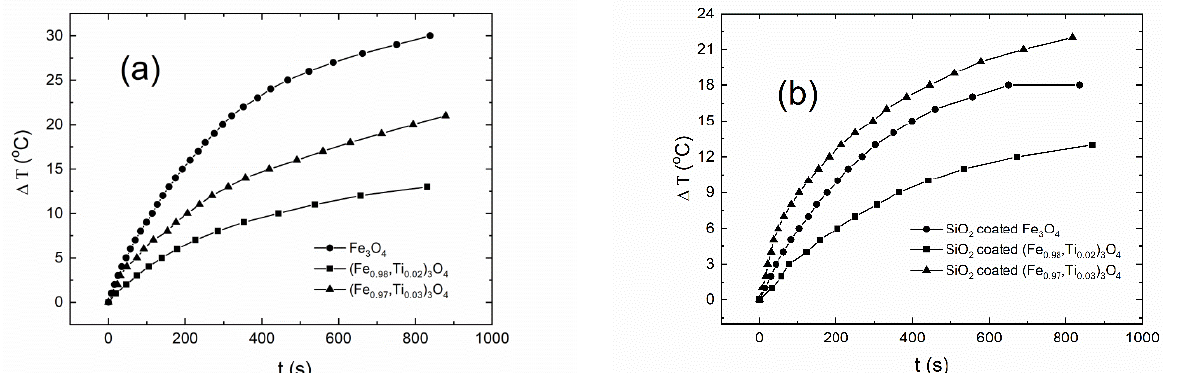
Figure 6. The magnetic heating performance of ( a ) uncoated and ( b ) SiO 2 coated pure and Ti doped Fe 3 O 4 .